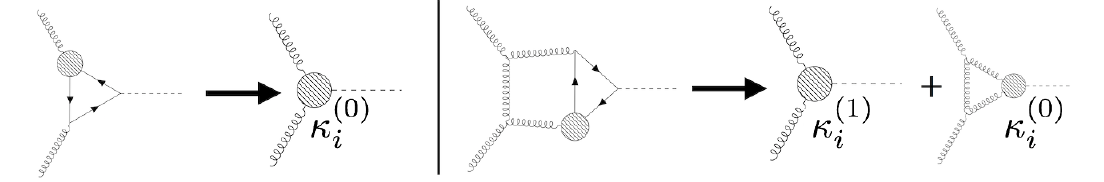
Figure 3 . Diagrammatic description of the matching between the SMEFT and the in(cid:12)nite top mass EFT at LO (left) and at NLO (right). The NLO amplitude in the in(cid:12)nite top-mass EFT contains two elements: diagrammatic corrections, which contribute universally to the K -factors and Wilson coe(cid:14)cient corrections, which are